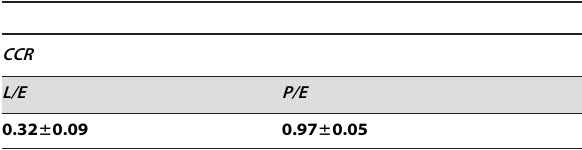
Table 7. Respiratory parameters from substrate-uncoupler- inhibitor titration protocol 3 (SUIT3) applied on equine permeabilized fibres of triceps brachii : coupling control ratio ( CCR ); ( N =15; trained horses matched with SUIT1 and SUIT2